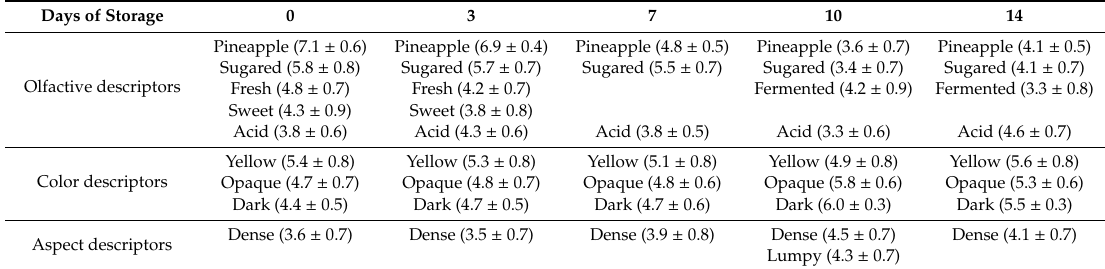
Table 5. Main olfactive, color, or aspect descriptors of freshly prepared and stored untreated juice, in descending order of occurrence. Descriptors used by at least 1 / 3 of the panel are presented. Mean score values and standard mean errors are added in parentheses.